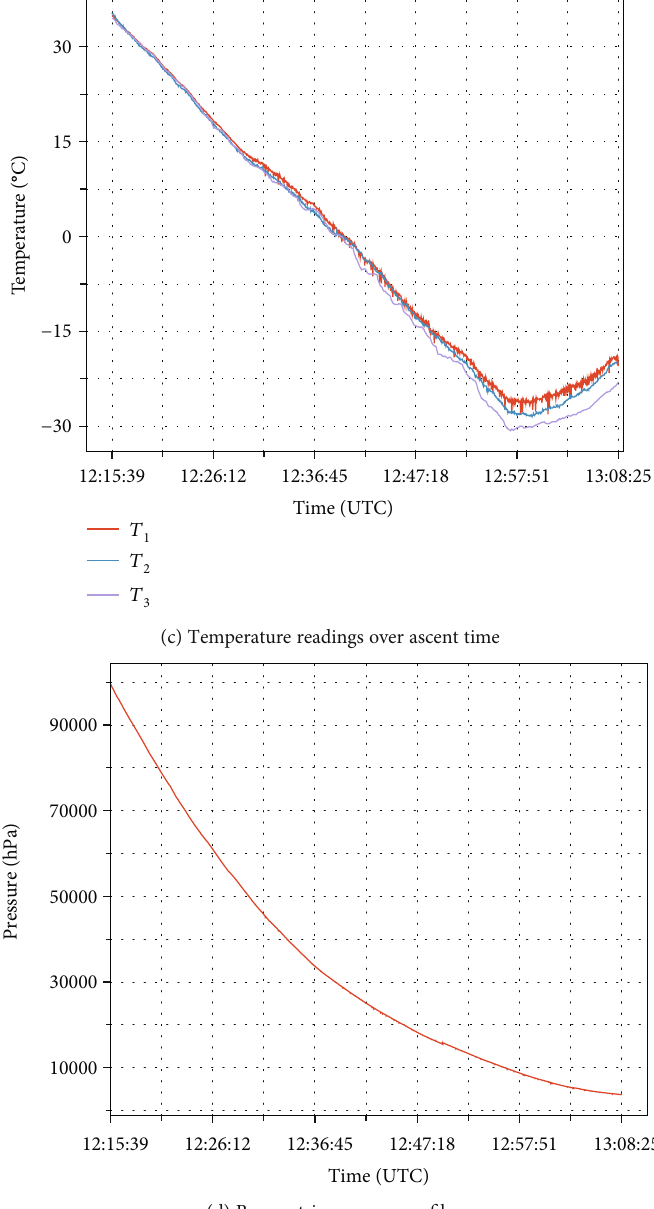
Figure 17: Readings of di ff erent variables of the S2-2 module as a function of the ascent time of the high-altitude balloon until its